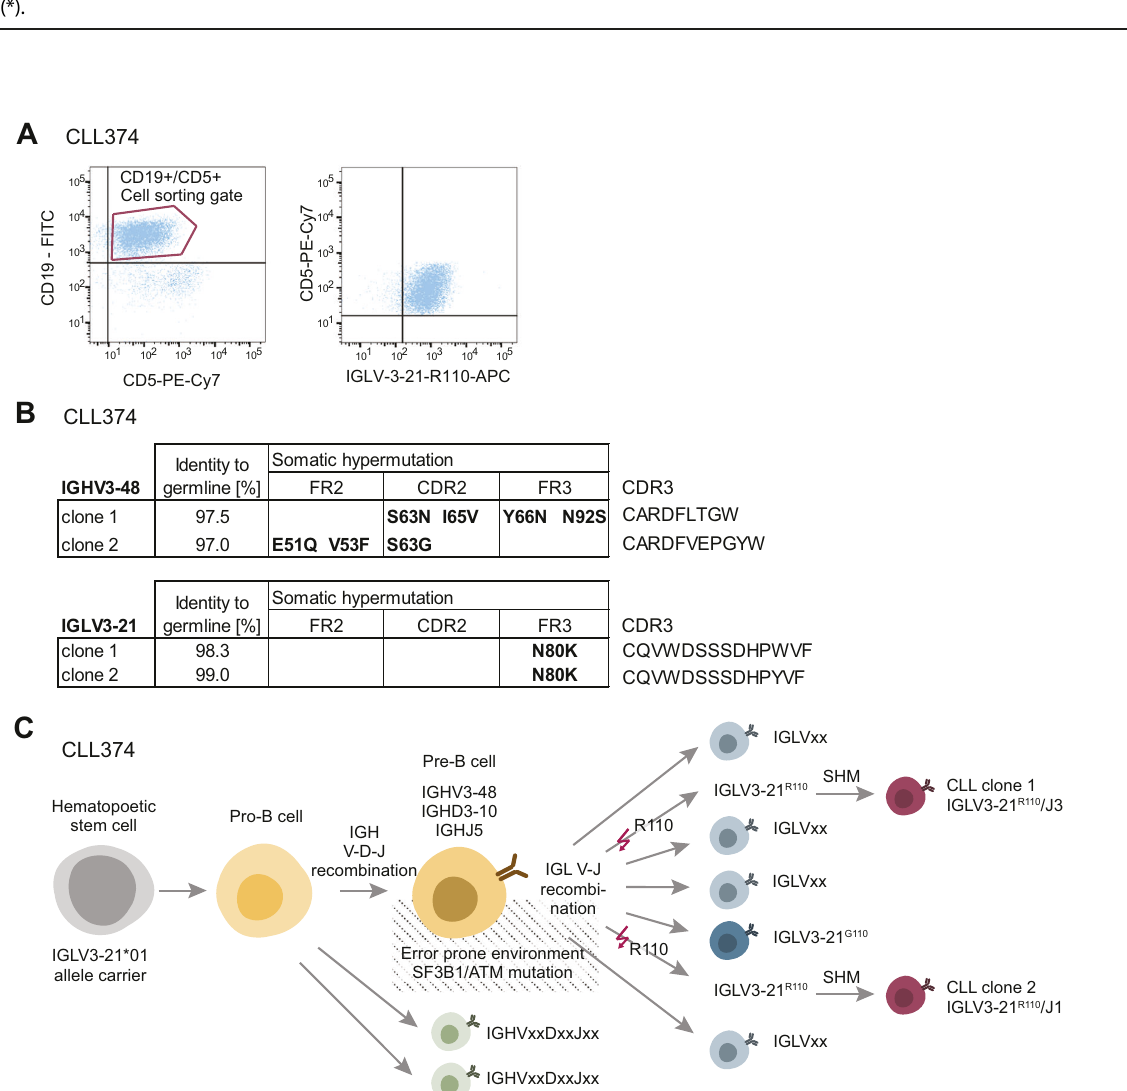
Fig. 1 Overview of IGLV3-21 usage in the CLL cohort and subclonal landscape of IGLV3-21 R110 expressing CLL cases. A Screening of the CLL cohort for IGLV3-21 R110 via fl ow cytometry and con fi rmation of results by next-generation sequencing (NGS) of the B cell receptor light chain (LC) repertoire. B Mutational pro fi le of IGLV3-21 R110 expressing CLL cases. C Analysis of the IGLV3-21 immune repertoire in patients with IGLV3-21 R110 expressing CLL. Frequencies of IGLV3-21 G110 and IGLV3-21 R110 sequencing reads are plotted. D Clonal distribution of the IGLV immune repertoire in 12 patients with IGLV3-21 R110 expressing CLL as well as 6 control cases with nonIGLV3-21 R110 expressing lambda CLL, kappa CLL or healthy donors (HD). One bubble represents one IGLV clone. The area size of the bubbles is proportional to the clonal frequency except for the main CLL clone which dominates the repertoires. Cases with diverging IGLJ in IGLV3-21 R110 bystander clones are marked with an asterisk (*).